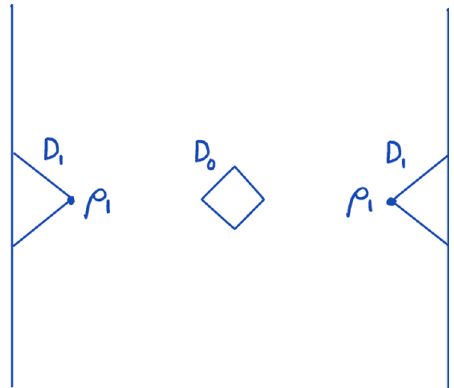
Figure 1 . Shown is a small causal diamond D 0 near the center of AdS, and a causal domain D 1 near its